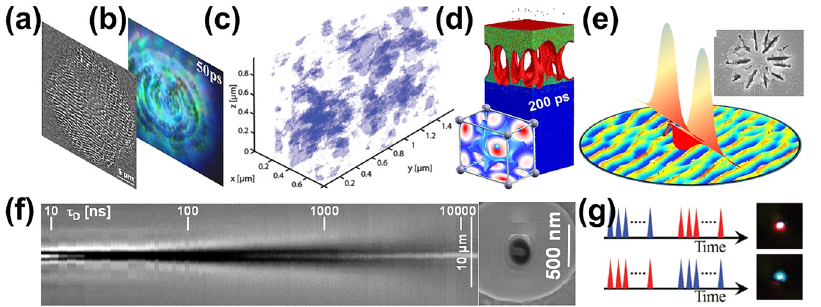
Figure 10: (a) Structured illumination microscopy for in situ imaging of nanostructured surfaces [129]. (b) Transient microscopy image